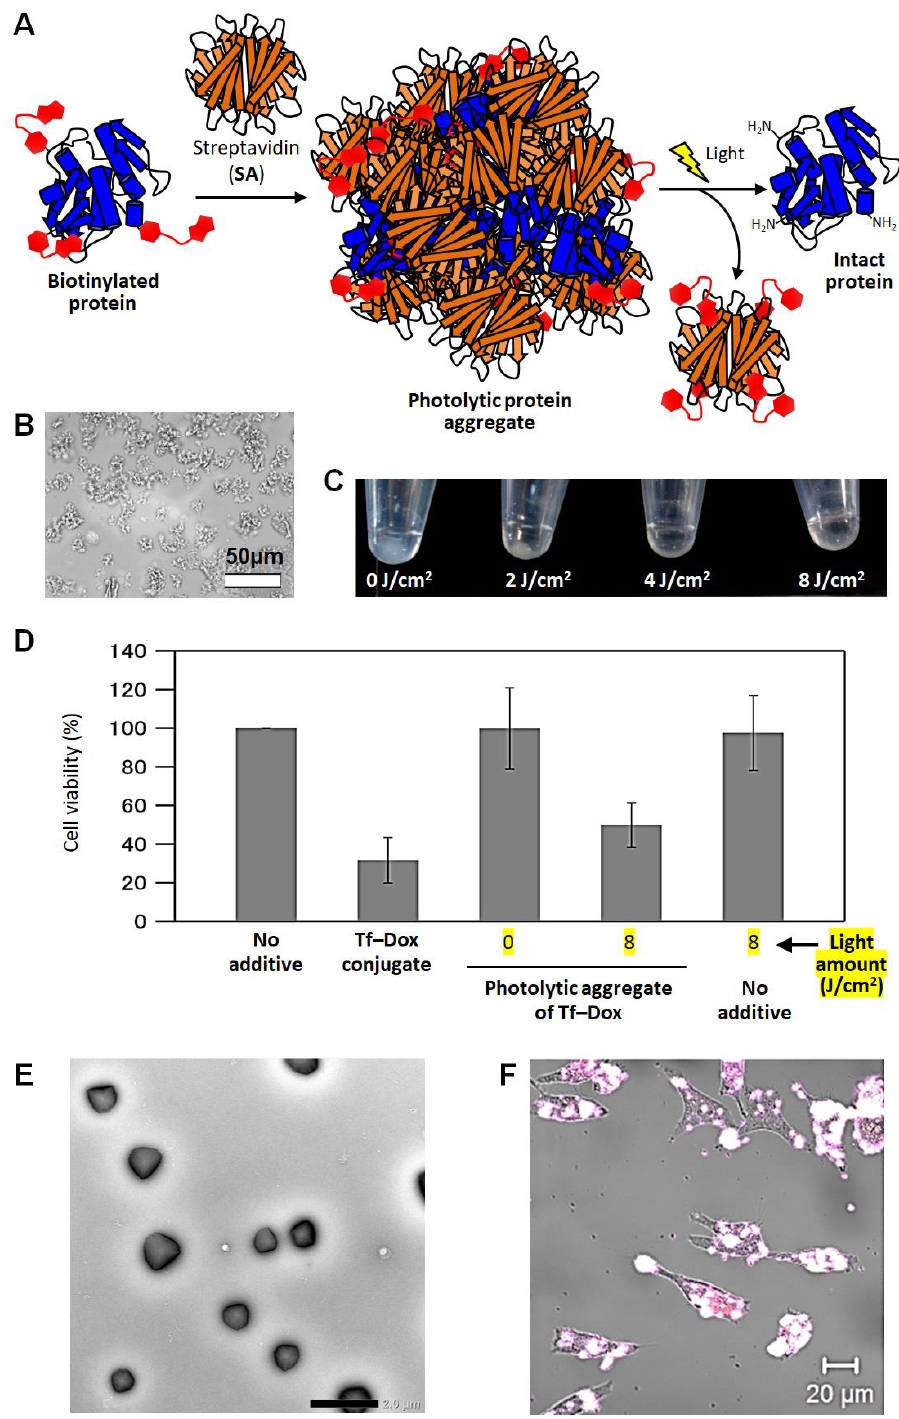
Figure 5. Photolytic protein aggregates using biotinylated caging reagent and streptavidin (SA). ( A ) Schematic illustration of photolytic protein aggregates. ( B ) Microscopic image of photolytic aggregates of lysozyme (HEL). ( C ) Photographs of photolytic HEL aggregates collected at the bottom of the tube by centrifugation after light irradiation (0–8 J/cm 2 ). ( D ) Cell viability of colon cancer DLD1 cells treated with photolytic aggregates of transferrin – doxorubicin conjugate (Tf – Dox) before and after light irradiation. ( E ) Electron microscopy images of photolytic HEL nanoaggregates prepared in a w/o emulsion. ( F ) Confocal microscopy images of DLD1 cells treated with cell-permeable peptide-modified photolytic HEL nanoaggregates. All figures are modified from the published article [73].